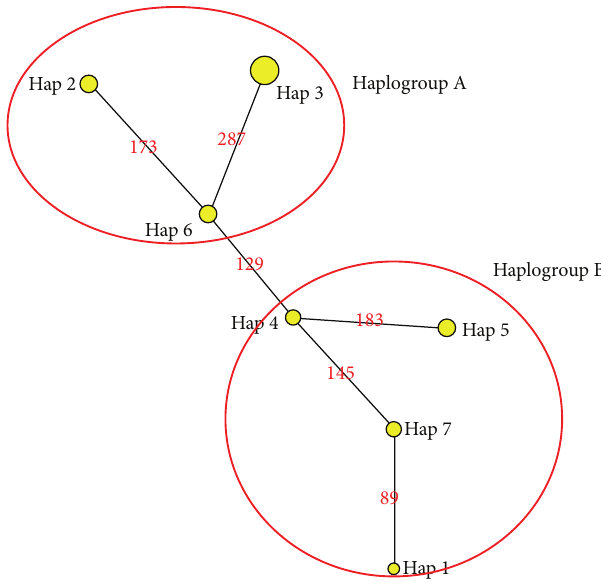
Figure 5: Minimum-spanning network of haplogroup A and haplogroup